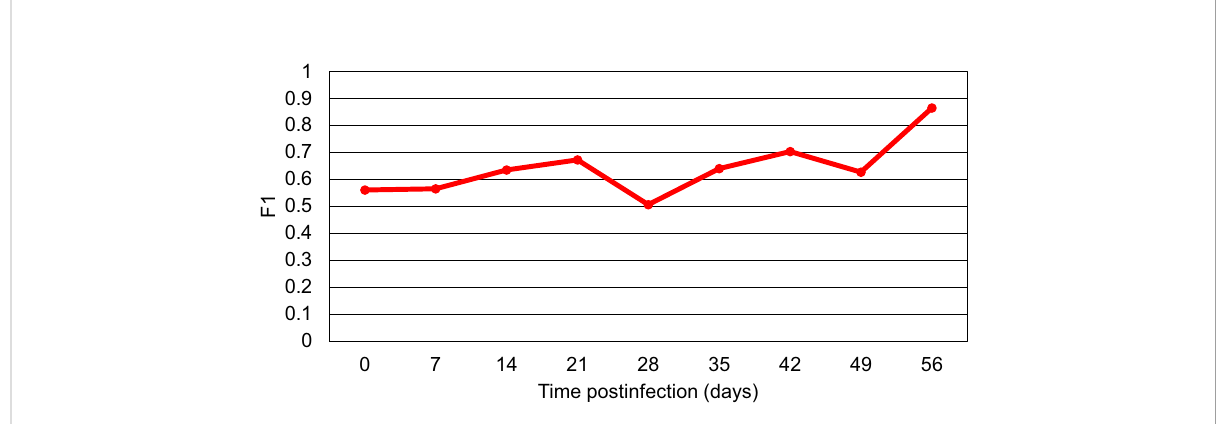
FIGURE 4 The F1 scores for the models comparing blood samples of all Borreliella -infected mice to blood samples of all uninfected controls for each time point. Mouse blood was sampled from C3H mice prior to their infection and postinfection with B afzelii Pgau (PGAU), B garinii PBi (PBI), or B burgdorferi N40 (N40). The blood was also collected from age- and sex-matched uninfected (control) C3H mice.